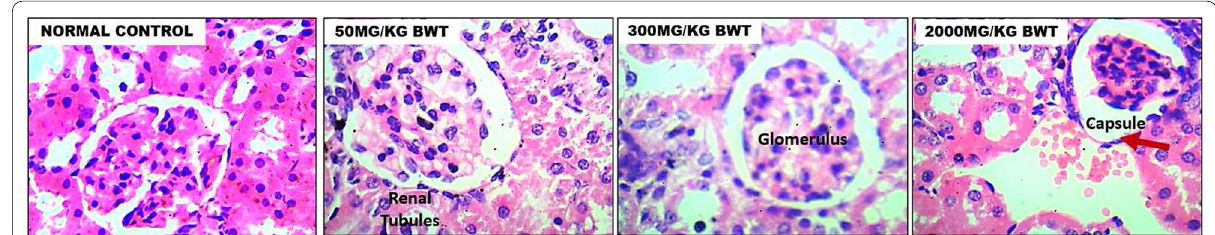
Fig. 5 Kidney micromorphological section demonstrated by Haematoxylin and Eosin staining at high magnification (X400). The renal cortex, renal tubules, glomeruli and mesengial cells are all appreciable across the various groups. Areas with marked morphological alteration are indicated by red